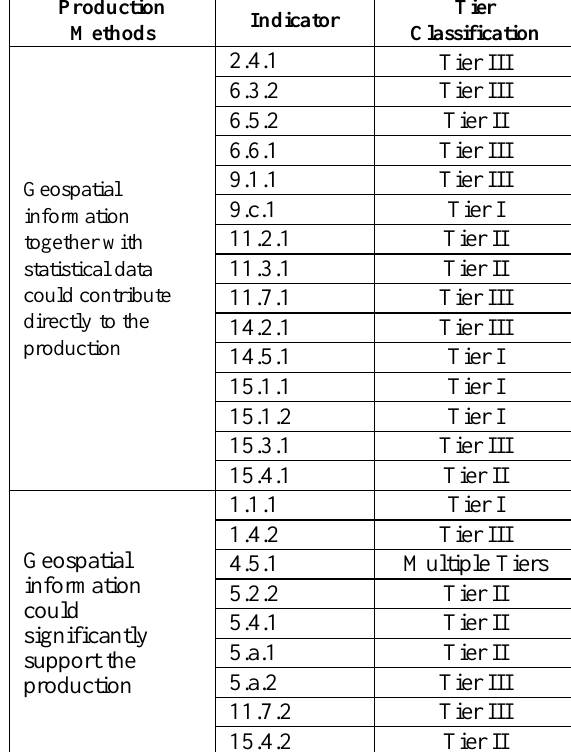
Table 3. List of Indicators where geospatial information